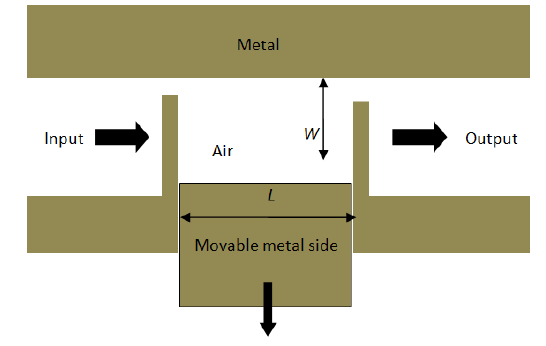
Fig.8. Schematic diagram to the vertical movement of the plasmonic filter There are different methods to adjust the effective index using electric field, for example Pockels effect, and Kerr effect . In the Pockels effect method, the refractive index is linearly proportional to the strength of the applied electric field. In Kerr effect method, the refractive index is proportional to the square of the applied electric field [12].